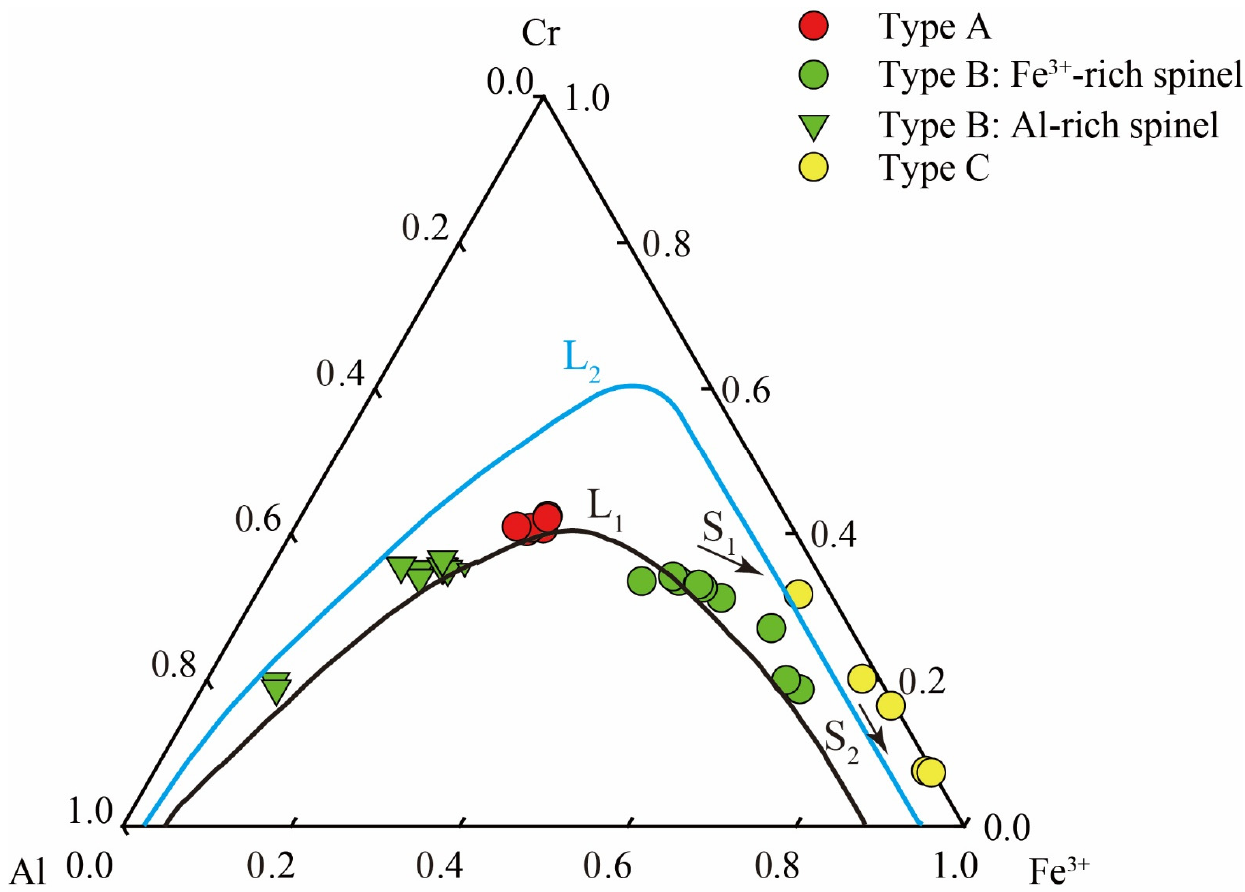
Figure 10. Ternary diagram of Cr-Al-Fe 3+ of spinel from the Duke Island complex. The L1 solid line is a calculated solvus for spinel coexisting with Fo80 olivine at 600 °C (Sack and Ghiorso, 1991), and the L2 solid line is a suggested solvus at 600 °C for unmixed spinel from the Red Lodge district [48]. S1 and S2 are two stages of alteration,